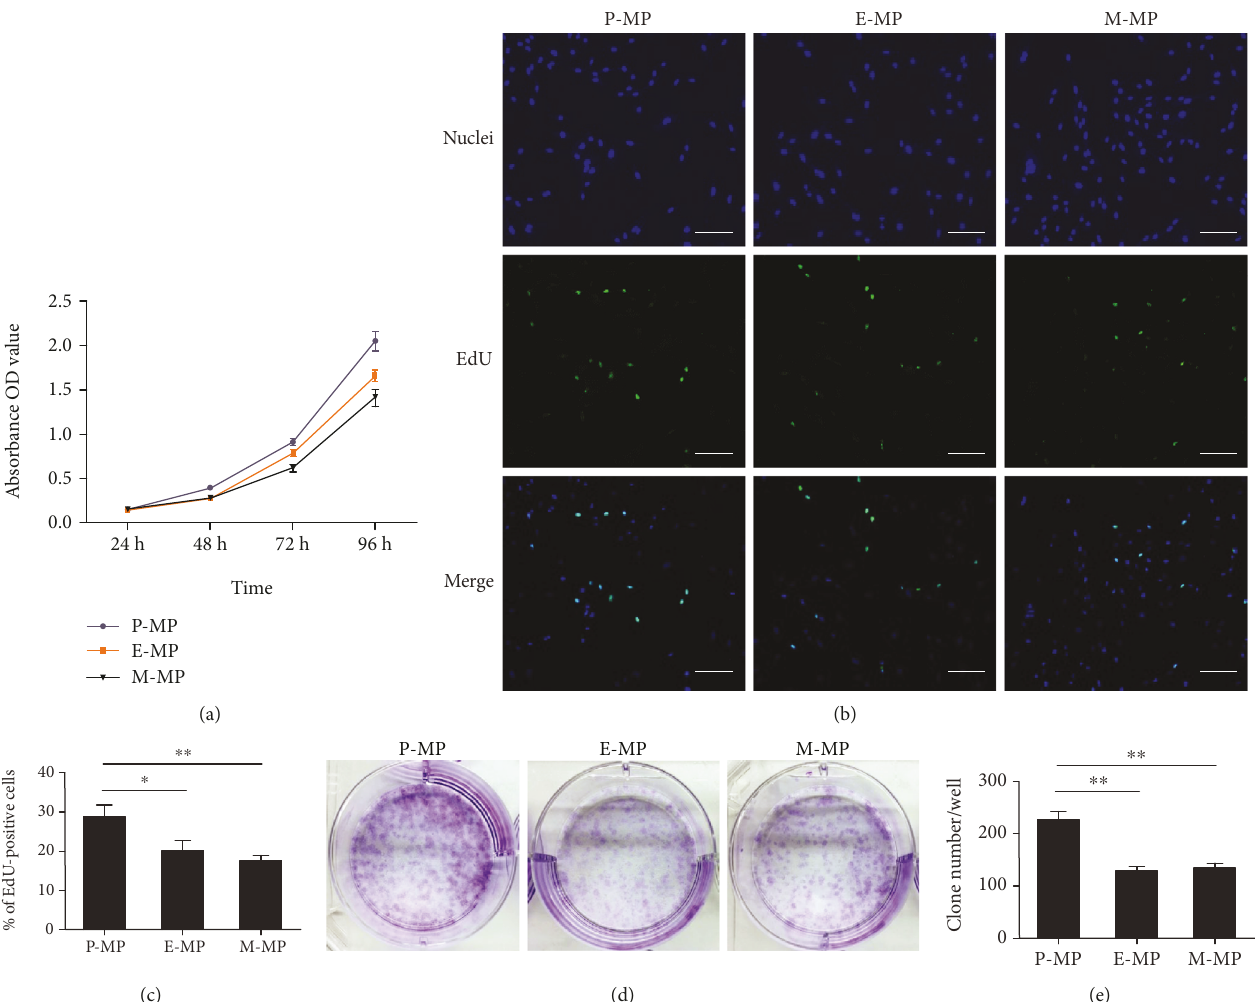
Figure 2: P-MPs displayed higher proliferative and clonogenic abilities. (a) The cell viability was measured with the CCK-8 assay at 24, 48, 72, and 96 h after seeding, and the curves were drawn according to the data of absorbance. (b) The EdU assay was used to analyze the proliferation of MPs. Hoechst 33342 for nuclear staining (blue). (c) EdU-positive cells (green) were counted to calculate the percentage. Scale bar, 100 μ m. (d) The CFU-F assay exhibited di ff erent clonogenic potentials in the three groups. (e) The clone number ( cells ≥ 50 )/dish was counted. Data was shown as mean ± SD . ∗ p < 0 05 ; ∗∗ p < 0 01